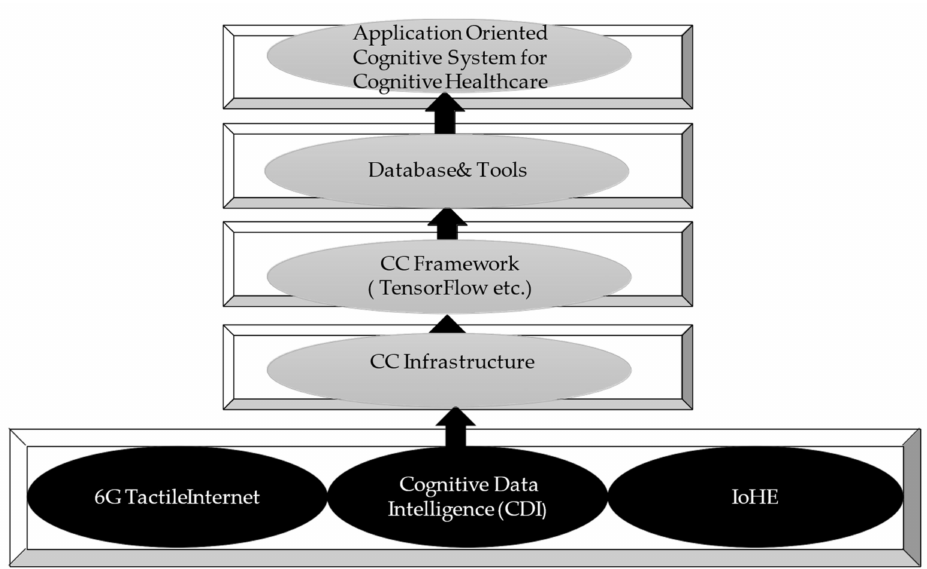
Figure 11. Cognitive system architecture for cognitive